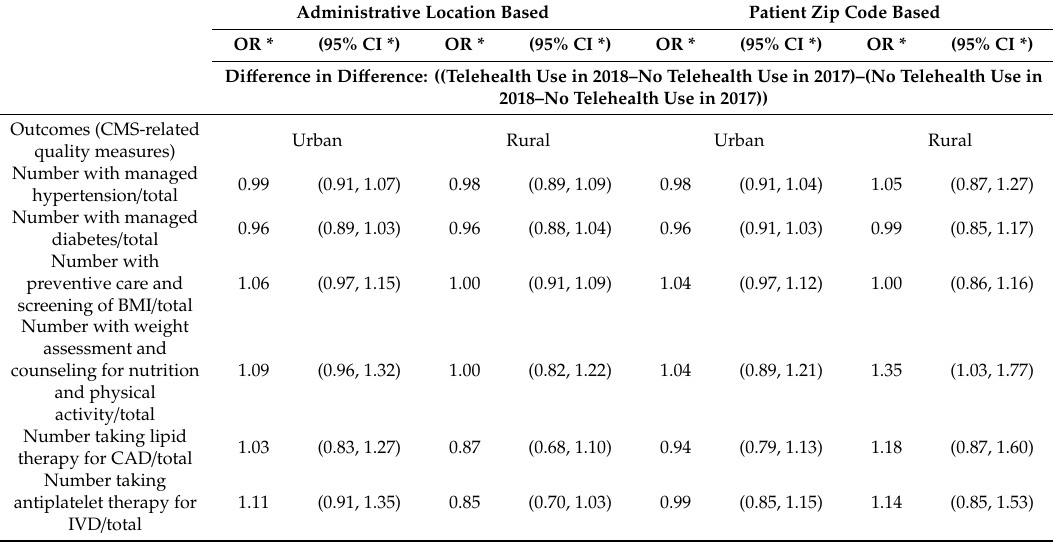
* GEE models stratified by location and accounting for CHCs nested within states and adjusted for race / ethnicity, payer mix, poverty level, organization size, along with the percentage of patients with specific conditions in that CHC, and the ratio of the number of total CHC patient visits / total patients. Significance level: p < 0.05; CMS: Cardiometabolic Syndrome; OR: Odds Ratio; CI: Confidence Interval; CAD: Coronary Artery Disease; IVD: